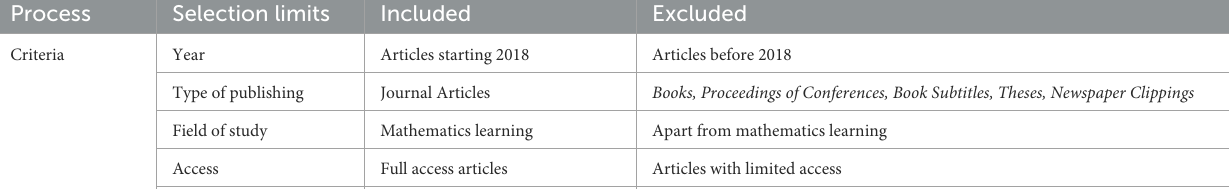
FIGURE1 PRISMA systematics review adapted from Page et al. (2021).